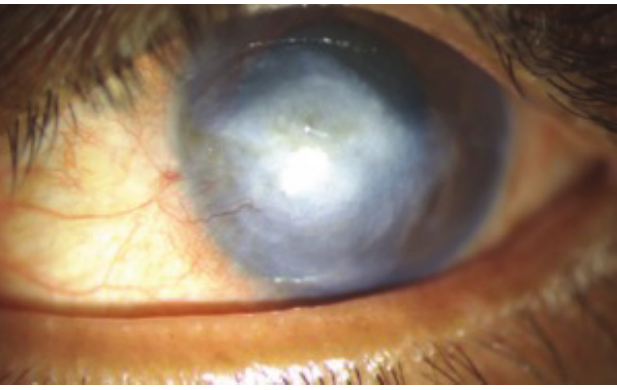
Figure 3. Healed ulcer with central scarring and peripheral